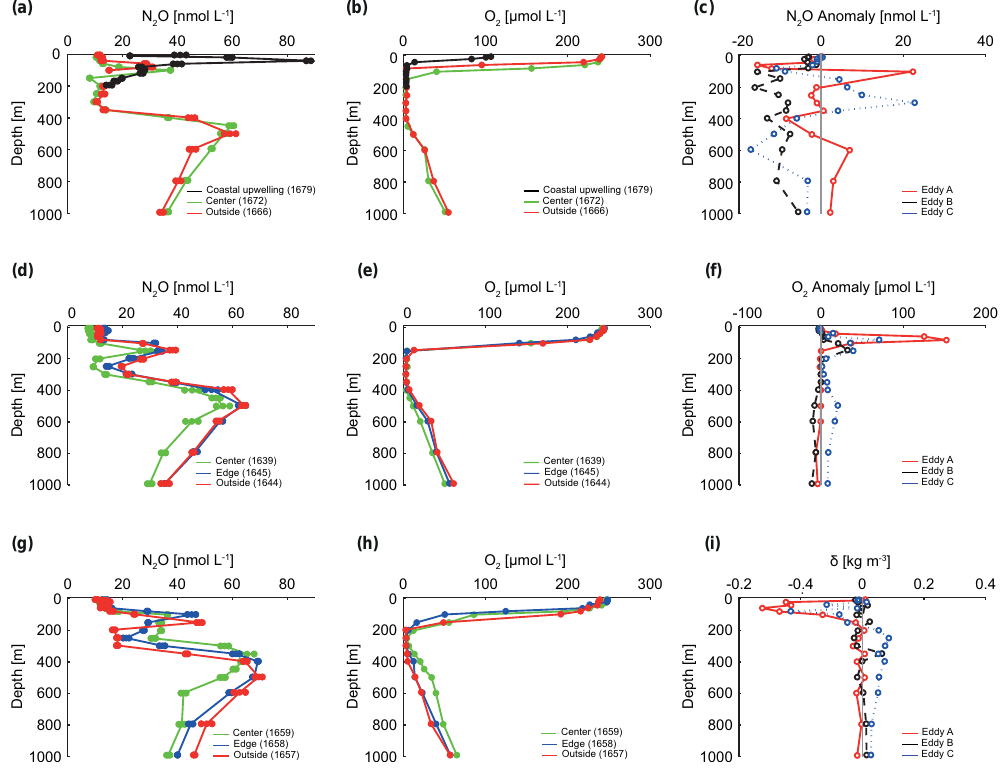
Figure 3. Vertical of distribution of N 2 O and O 2 across the mode water eddies A (a–b) and B (d–e) , and the cyclonic eddy C (g–h) during the M90 cruise in November 2012. Selected depth profiles of N 2 O and O 2 are shown in (a, d, g) and (b, e, h) , respectively. Black lines/symbols in (a) and (b) indicate the northwesternmost station of eddy A, at which the influence of coastal upwelling was observed. Numbers in parentheses indicate the station numbers (cf. Fig. 1). For N 2 O the standard deviation from triplicate samples is depicted by circles around the concentration values at each depth. N 2 O, O 2 , and density ( δ) core anomalies for the eddies sampled during M90 are shown in (c) , (f) , and (i) ,